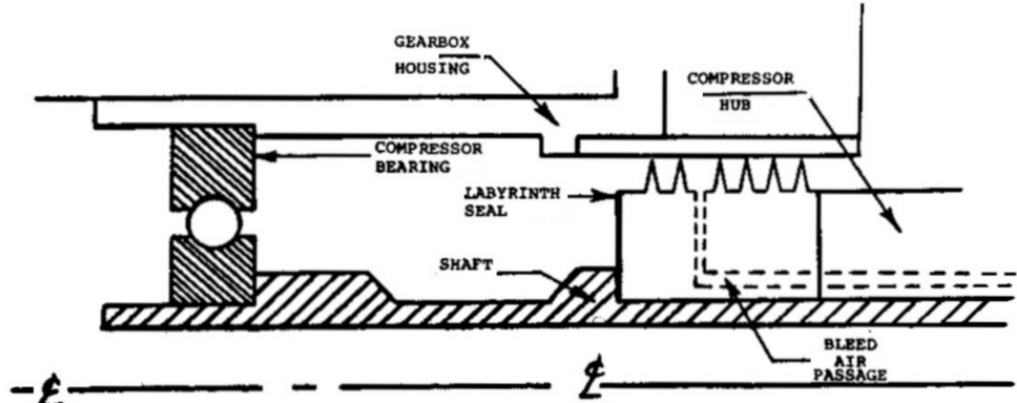
Figure 6. Labyrinth seal close to the main shaft compressor bearing (based on Figure 11 in [16]). Note: The carbon seal is located in between the compressor bearing ( on the left ) and the labyrinth seal ( on the right ) in the empty space but is not shown in this figure.